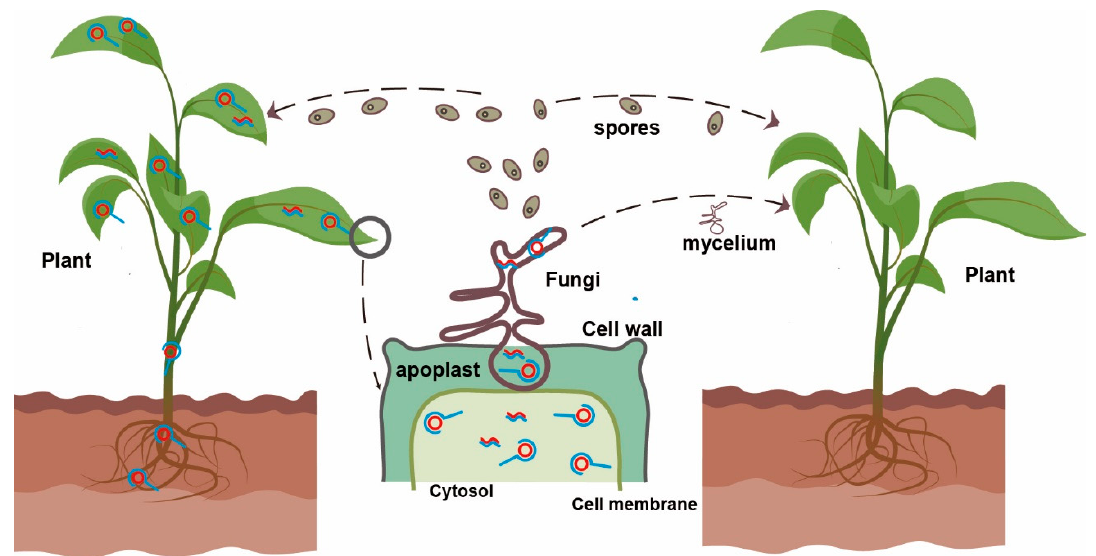
Figure 1. A model of viroid replication and transmission between plants and fungi. As a natural host of viroid and fungi, plants support viroid replication (shown for the plant on the left); viroid rolling-circle replication in plant and fungal cells is indicated by red and blue lines. Fungus, a potential viroid host, coincidentally infects the plant carrying the viroid. Viroid-fungus-plant interaction occurs in the apoplastic space of plants; viroid can then be acquired by the co-infected fungus and spread by the mycelium or by fungal spores. Replication in the fungal cells is also possible if the host is suitable.